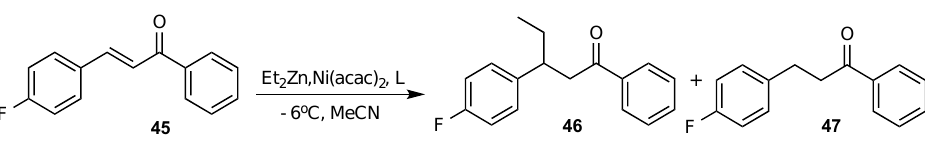
Table 5. Content of compounds 45 , 46 and 47 in reaction mixtures after 15, 30 and 60 min from the start of the